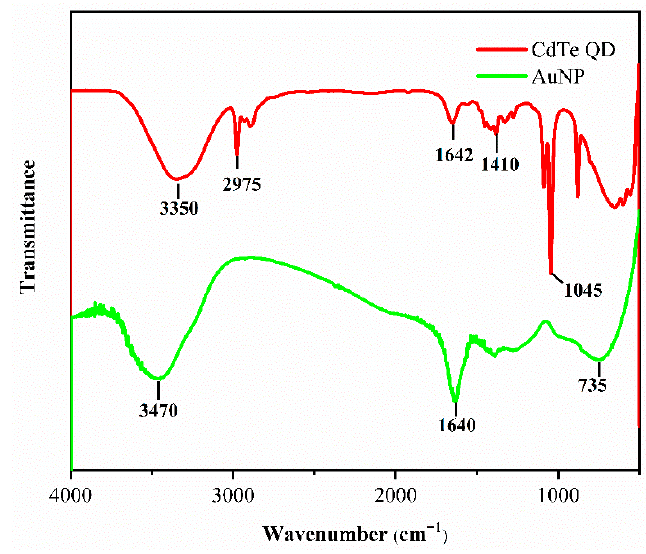
Figure 3. FT-IR spectra of CdTe QD and AuNP.